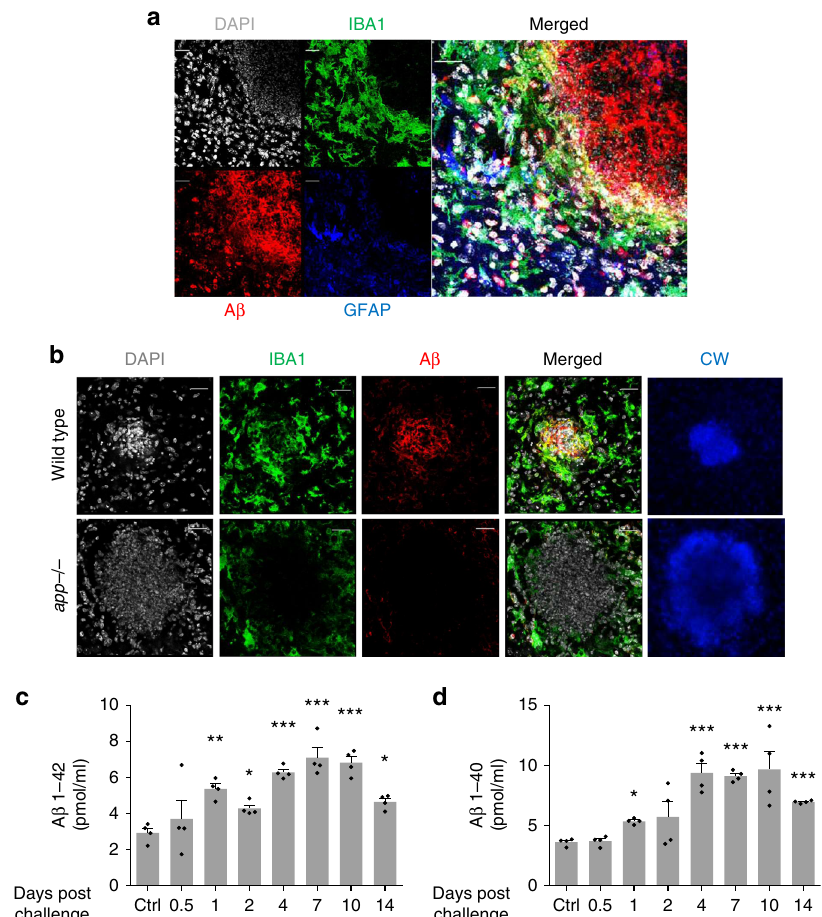
Fig. 4 Amyloid β binds directly to Candida albicans in vivo. a Wild-type mice were challenged with C. albicans as in Fig. 2, and immuno fl uorescence staining for DAPI, IBA1, A β , and GFAP was performed on brain sections containing fungal granulomas. b Repeat staining of fungal granulomas for DAPI, IBA1, A β , and calco fl uor white (CW) comparing wild-type to app − / − mice. c , d A β 1 – 42 and 1 – 40 levels from whole-brain homogenates as assessed by ELISA. ( n = 4, mean ± S.E.M, * p < 0.05, and ** p < 0.01 using one-way ANOVA followed by Dunnett ’ s test for multiple comparison. Scale bar: 20 μ m). Data are shown